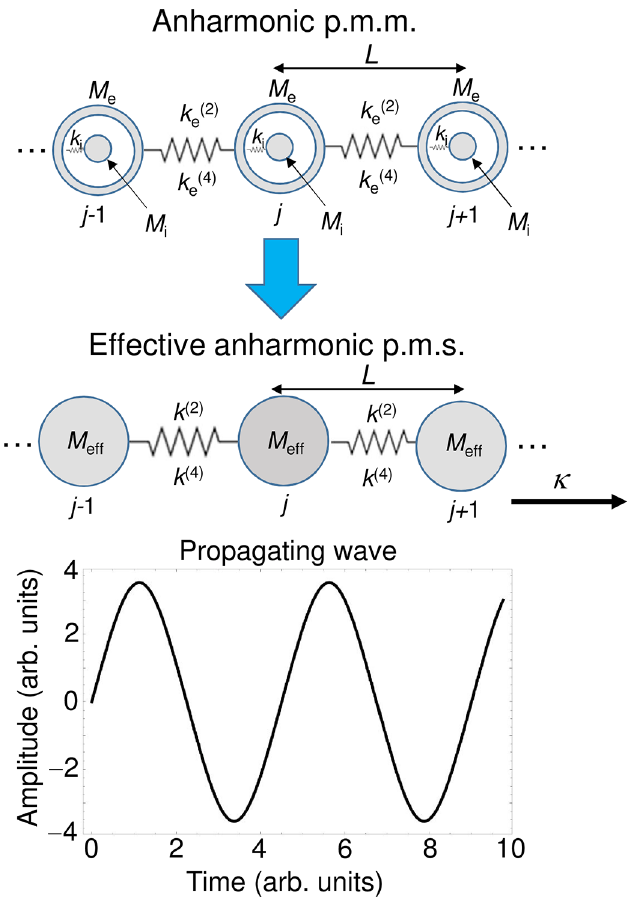
Fig. 1. Sketch of the anharmonic p.m.m. system and of the effective anharmonic p.m.s. system. The time pro fi le of the main propagating wave in the effective anharmonic p.m.s. system is also